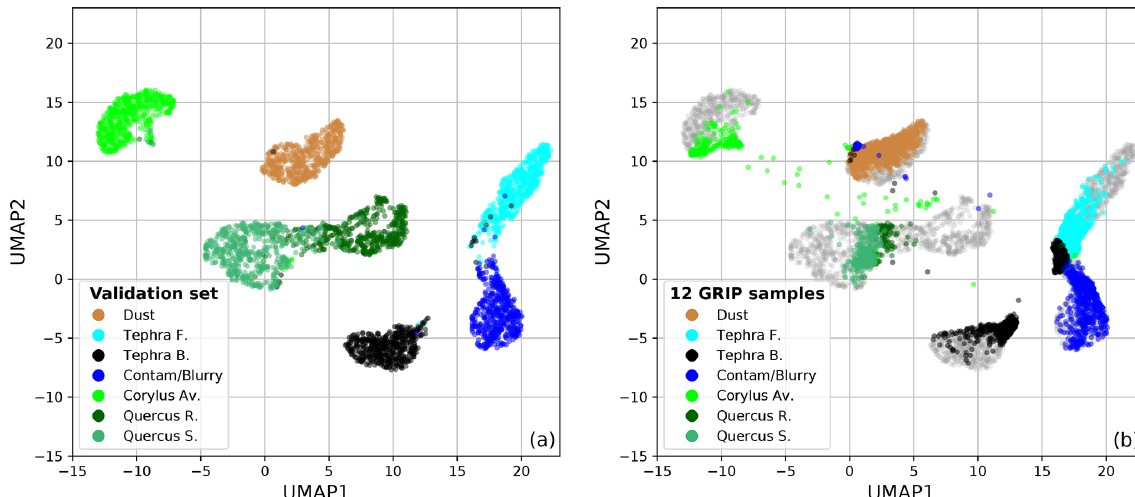
Figure 8. UMAP 2-d visualization of the network 64-d layer of the CNN branch. In panel (a) , UMAP is run on the validation dataset. In panel (b) , the learned UMAP space is used to project all images of the n = 12 GRIP samples. The items are color-coded according to their predicted class. Gray items represent the validation items.